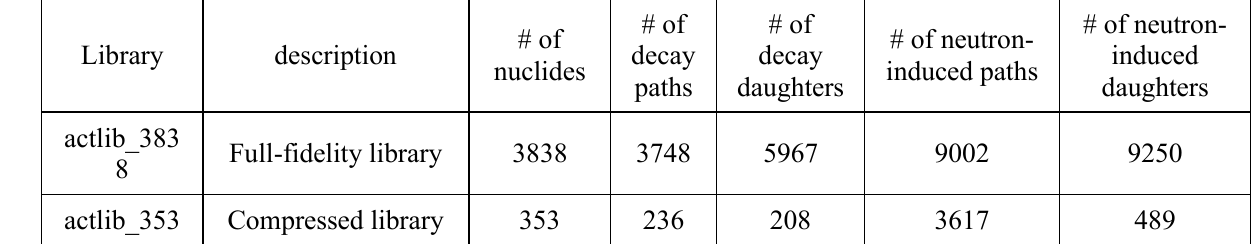
Table II. Main characteristics of the full-fidelity library and new compressed